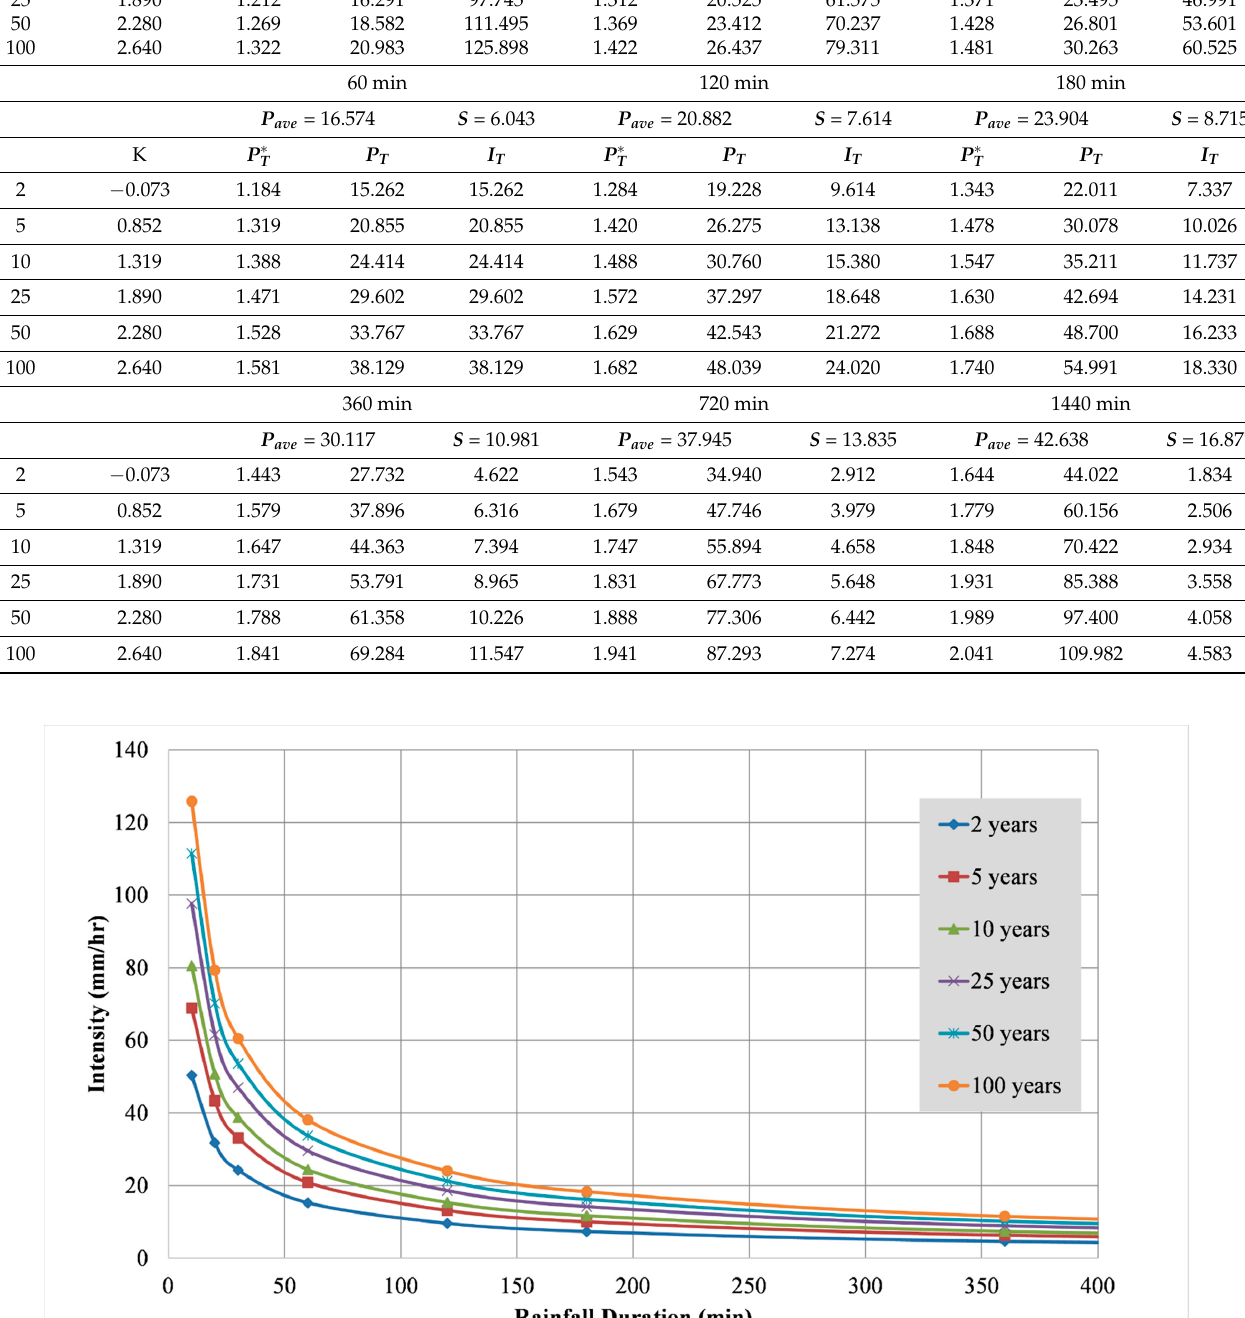
Figure 7. IDF curves generated using the LPT III method on a log-log scale.